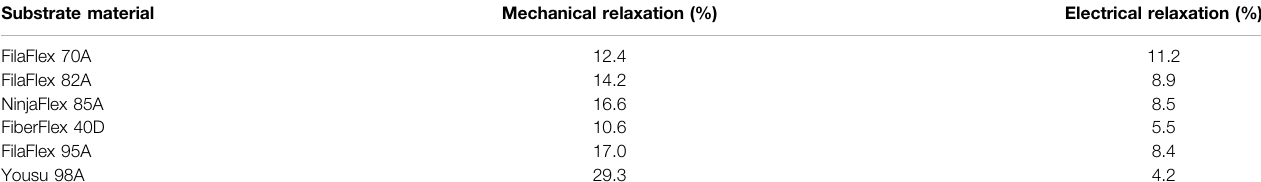
TABLE 5 | Mechanical and electrical relaxation for TPU strips with the integrated in situ sensing elements, measured during the dynamic tensile test with a dwell time of30 s at 30% strain during the third cycle. The mechanical relaxation is derived from Supplementary Figure S7 and the electrical relaxation from Figure 7 . Substrate material